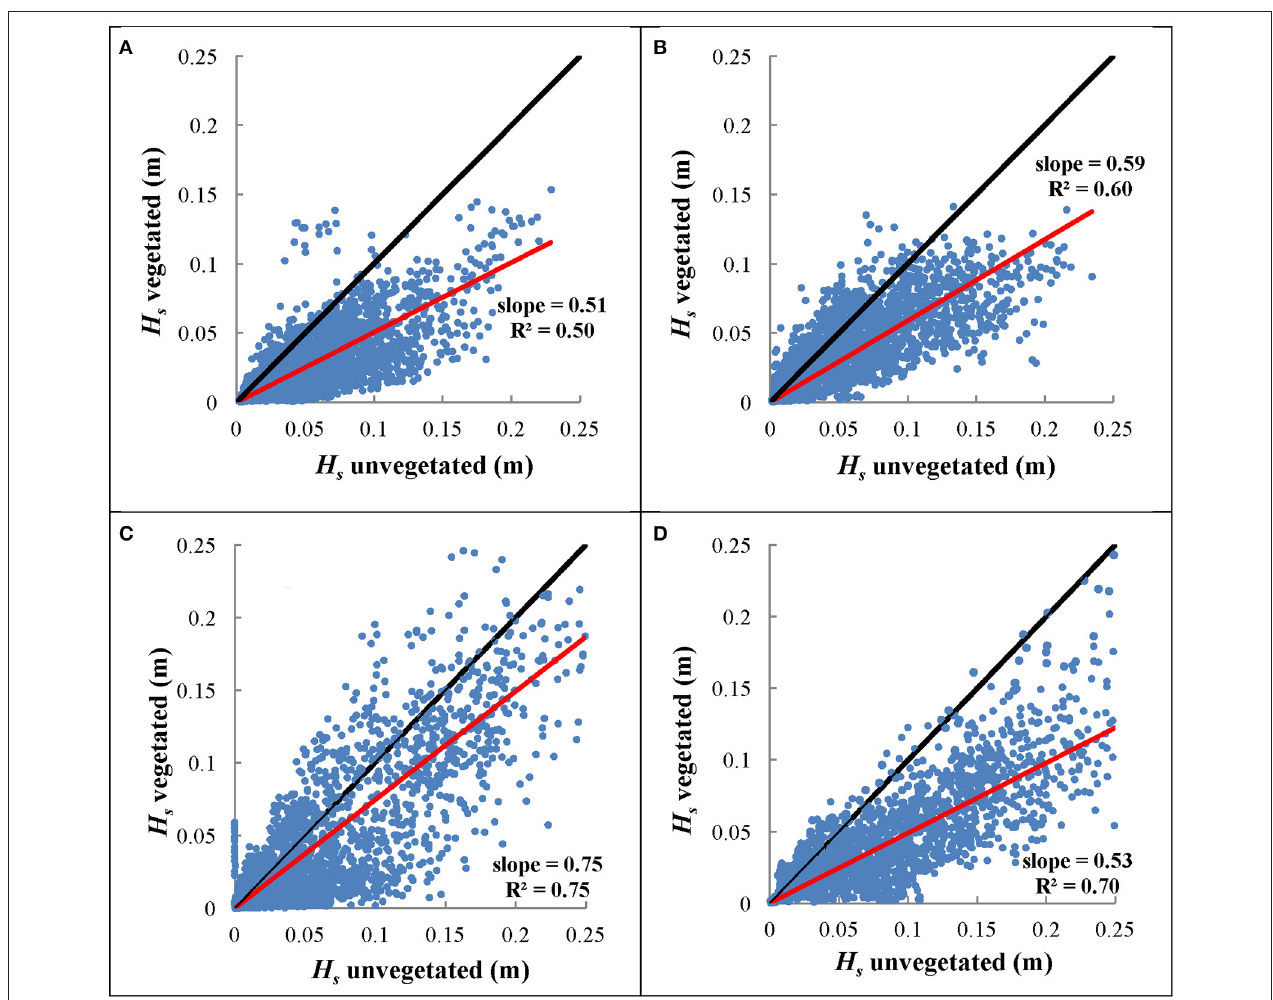
FIGURE 4 | Significant wave height at the center vegetated site compared to significant wave height at the nearby bare site over four seasons (A) summer 2012, (B) fall 2012, (C) winter 2013, and (D) spring 2013. The slope of the regression line represents the degree of wave height attenuation between these two sites, with shallower slopes indicating greater attenuation. The regression line was fit to pass through the origin. Black line represents 1:1 slope line, indicating a case with no attenuation between the bare and vegetated sites.